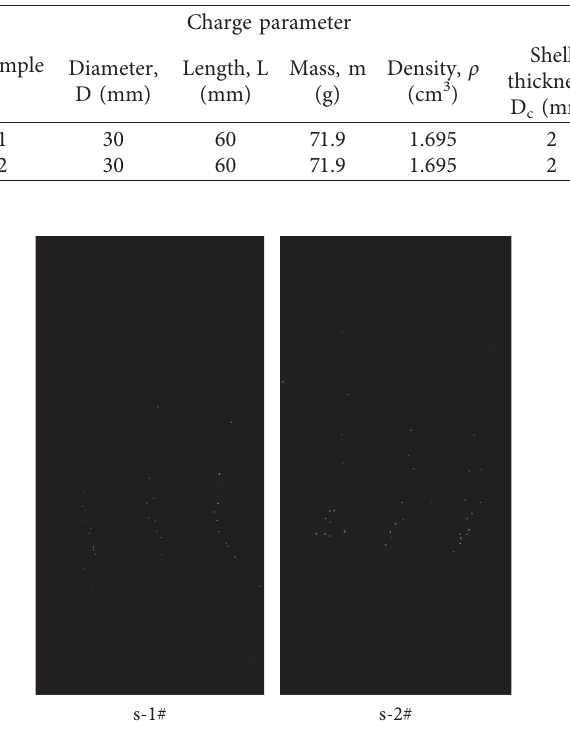
Figure 11: Picture of pit treatment on the witness plate after validation test. Figure 12: Test value of combat fragmentation dispersion